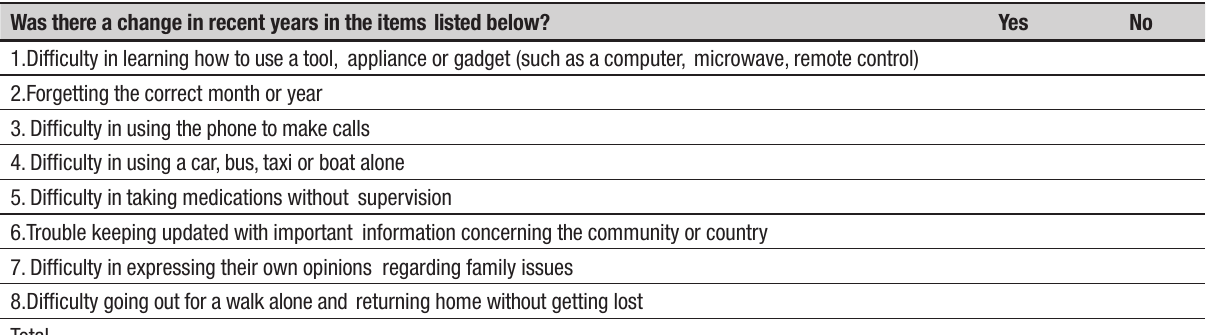
Table 2. Final Model of the CCQ8 (Portuguese version in Box 1). Was there a change in recent years in the items listed below? Yes No